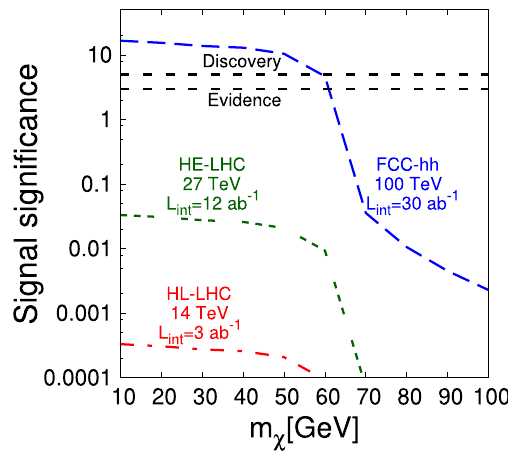
Fig. 11 Distribution of E ground processes. a m χ = 10GeV; b m χ = 0 . 5TeV and normalized to one